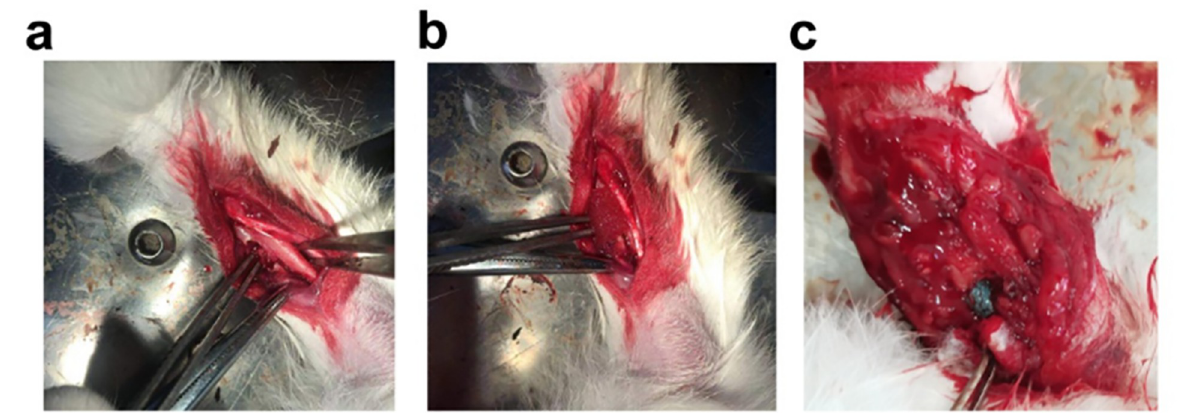
Fig 5. Construction of (a) radial segmental bone defect models (control group; n = 6 rabbits) and (b) rabbit radial segmental bone defect models accompanied by infection (infected group; n = 6 rabbits); (c) recanalization of bone marrow and implantation of CMs(GM)- β -TCP/gelatin composite scaffolds in the 4th week after model generation (experimental group; n = 3 rabbits). (CMs: Chitosan microspheres; GM: Gentamycin; β -TCP: β - tricalcium phosphate).